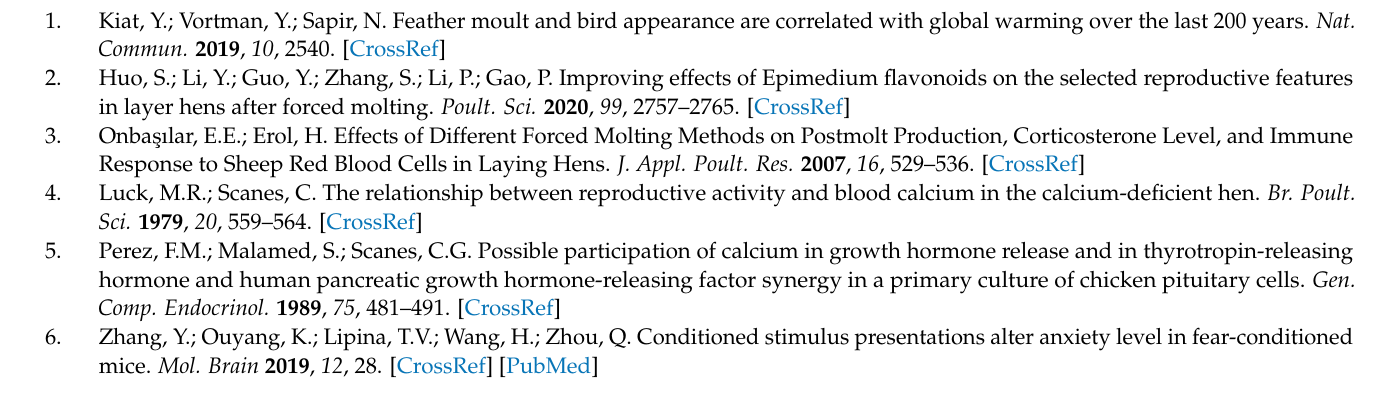
Table S2. Summary statistics for sequence quality of 30 samples, Table S3. DEGs between 10 groups in the hypothalamus and ovary, Table S4. DEGs whose expression trends were consistent with ELR were related to aging, autophagy or apoptosis, and development, Table S5. Top five genes in the network of the top 100 brown genes ranked by the MCC method, Figure S1. Significant GO enrichment of DEGs ( p < 0.05) for comparison of 1-vs-2 in the hypothalamus. BP (Biological Process), CC (Cell Component), MF (Molecular Function), Figure S2. Significant GO enrichment of DEGs ( p < 0.05) for comparison of 1-vs-2 in the ovary. BP (Biological Process), CC (Cell Component), MF (Molecular Function), Figure S3. Significant GO enrichment of DEGs ( p < 0.05) for comparison of 2-vs-3 in the hypothalamus, Figure S4. Significant GO enrichment of DEGs ( p < 0.05) for comparison of 2-vs-3 in the ovary. BP (Biological Process), CC (Cell Component), MF (Molecular Function), Figure S5. Significant GO enrichment of DEGs ( p < 0.05) for comparison of 3-vs-5 in the hypothalamus. BP (Biological Process), CC (Cell Component), MF (Molecular Function), Figure S6. Significant GO enrichment of DEGs ( p < 0.05) for comparison of 3-vs-5 in the ovary. BP (Biological Process), CC (Cell Component), MF (Molecular Function), Figure S7. Determination of the soft threshold ( β =8). The left panel shows the analysis of scale-free fit index and the right panel refers to the analysis of mean